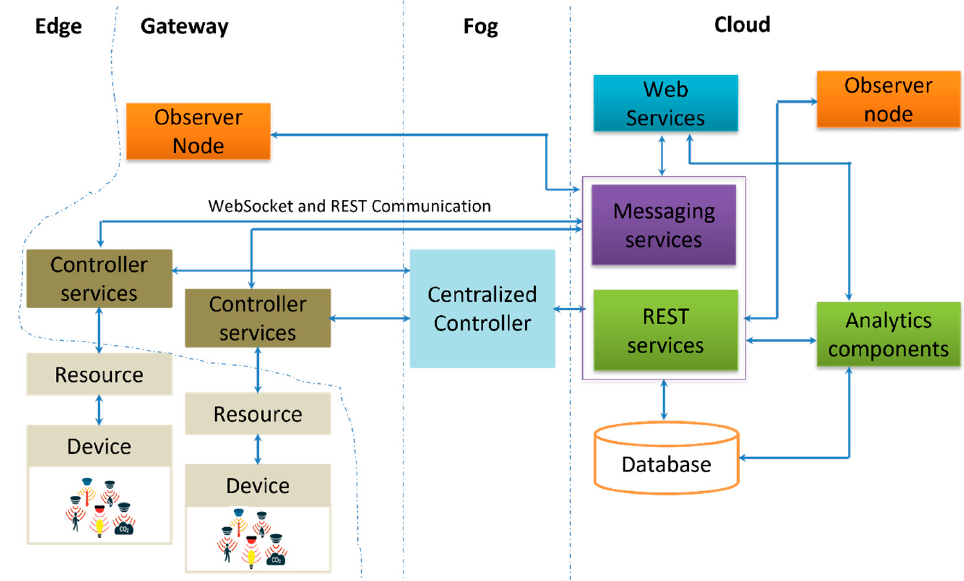
Figure 5. Deployment design of building monitoring IoT system.